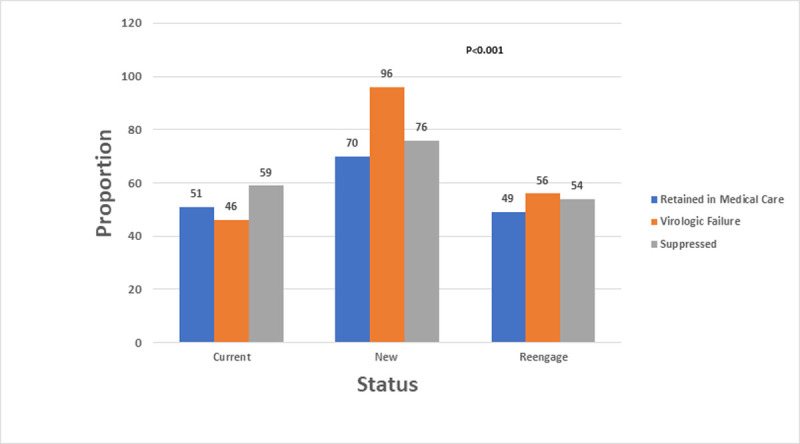
Retention in medical care, virologic failure and suppression by status, Peter Ho Clinic, 2013–2017.Note: Retention in medical care: Two medical encounters (medical visit or viral load), three months apart, in 2017, ART prescription and alive as of 12/31/2017. Virologic Failure: Most Recent Viral load > 200 copies/mL. Suppressed: Most Recent Viral load < 200 copies/mL. Status: Current patients were those in care in 2013. In the respective calendar-year, new patients were newly diagnosed and those reengaged did not previously receive care in PHC.